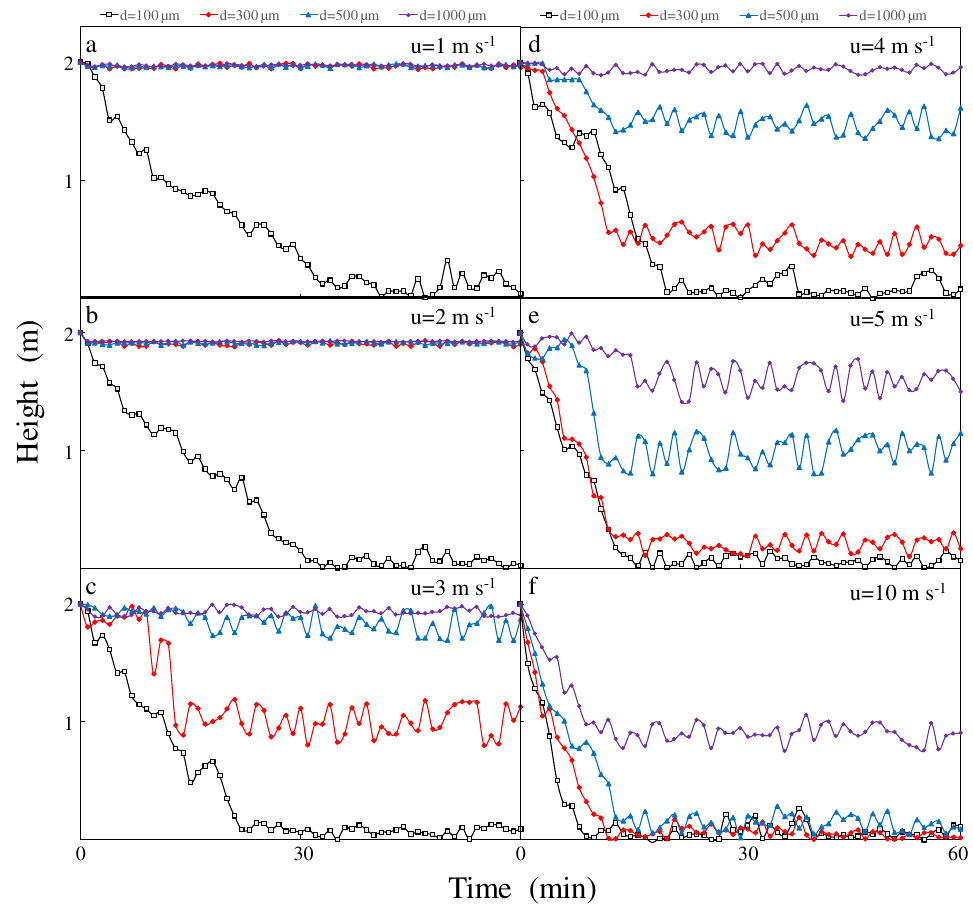
Figure 3. Vertical migration of Microcystis colonies at various constant wind speeds: ( a ) 1 m s −1 , ( b ) 2 m s −1 , ( c )